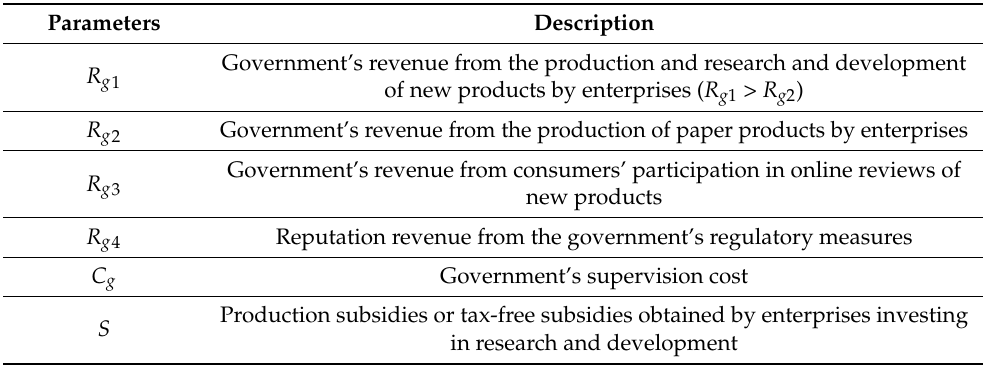
Figure 2. Structure of the government–enterprise game and the government–enterprise–consumer Figure 2. game. Table 4. Parameters involved in the model (g: government; e:enterprise; c: